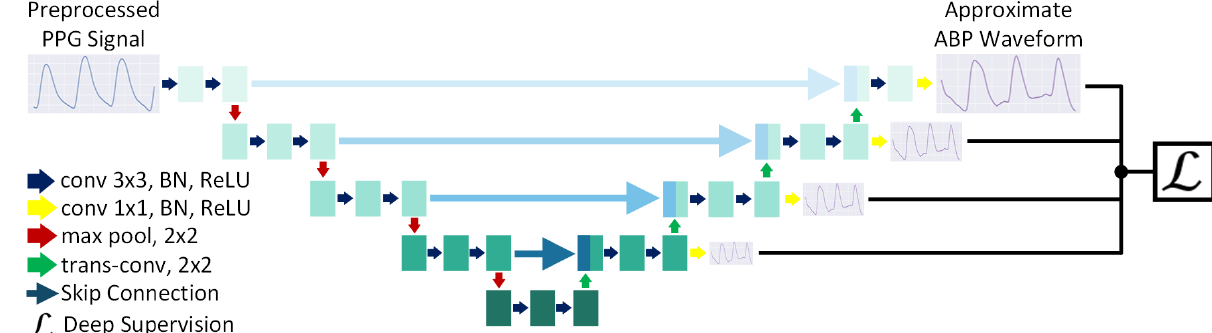
Figure 2. Approximation Network. PPG2ABP employs the Approximation Network to derive an approximate ABP waveform from the preprocessed PPG signal. The network is a deeply supervised one-dimensional U-Net, designed to solve regression problems.